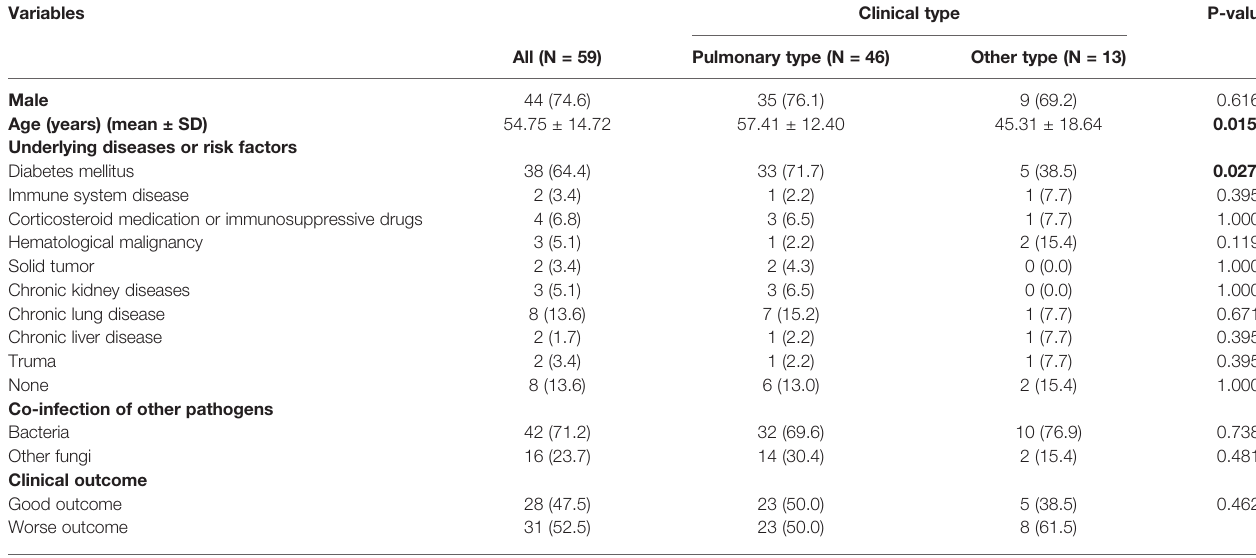
TABLE 1 | Demographic and clinical outcomes in patients with mucormycosis.